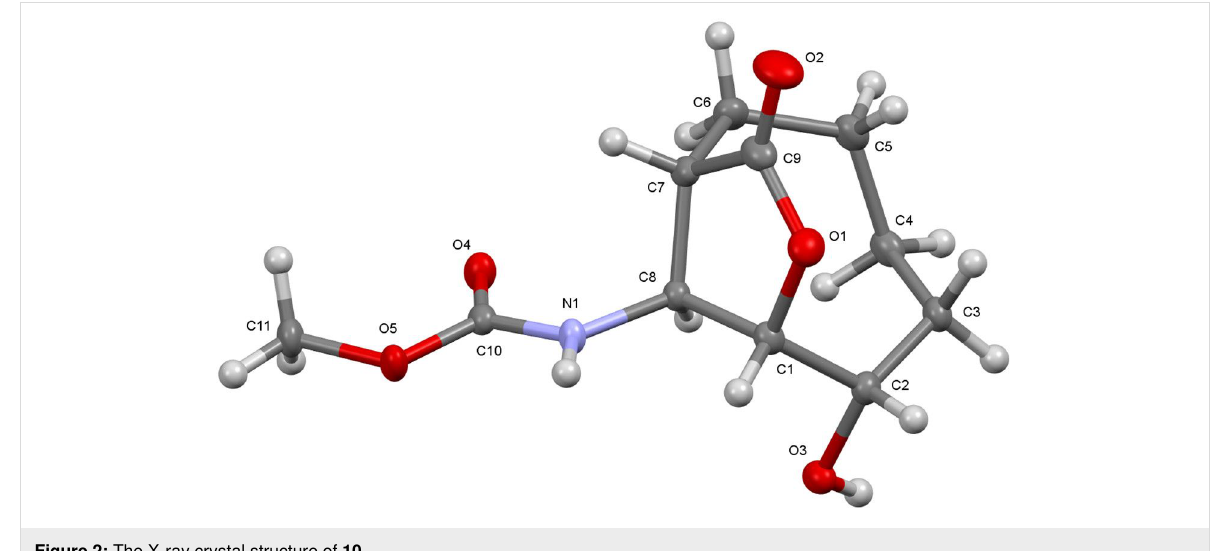
Figure 2: The X-ray crystal structure of 10 .